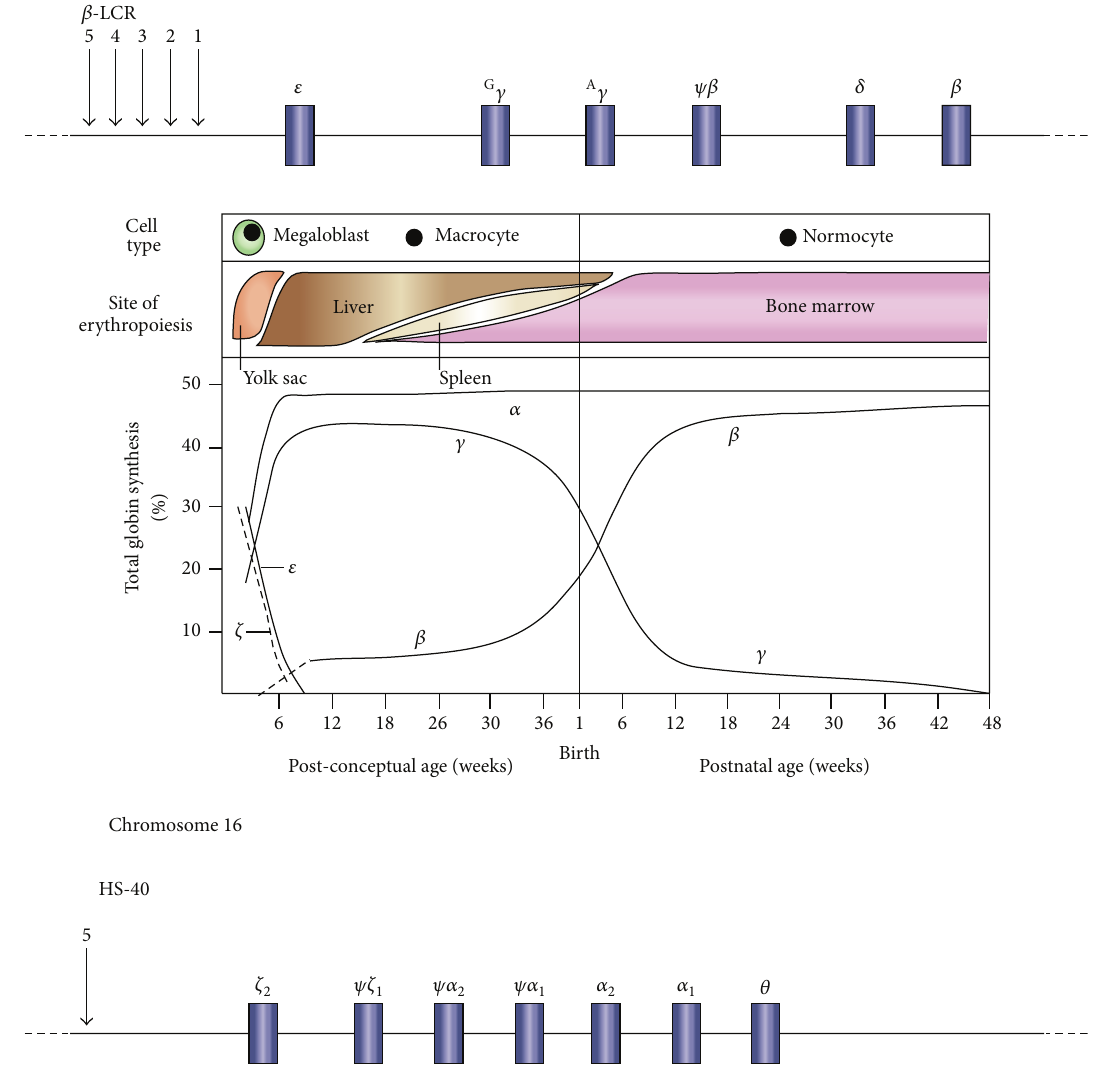
Figure 1: Developmental control of human haemoglobin (Hb) expression